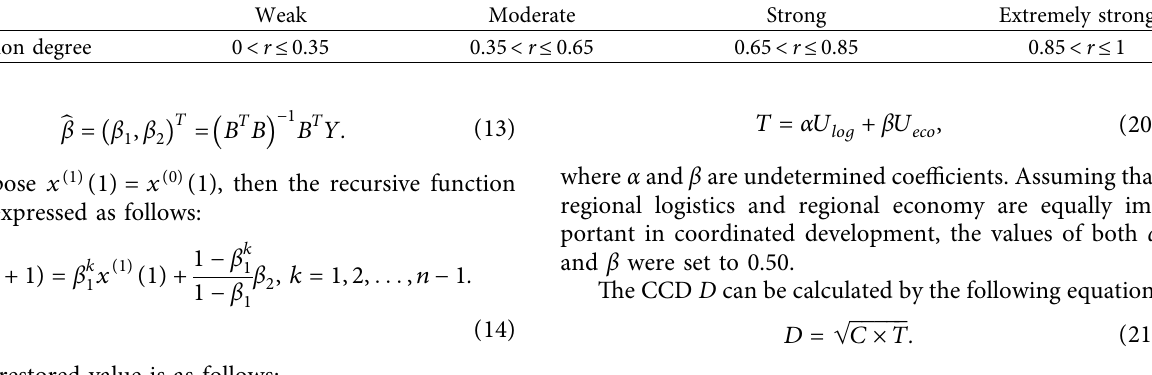
Table 1: Levels of correlation